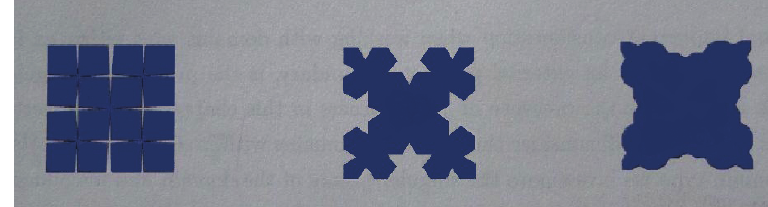
Figure 4: Pre-fractal Koch Islands Ω 2 α with α = 2.1, α = 3 and α = 3.75,